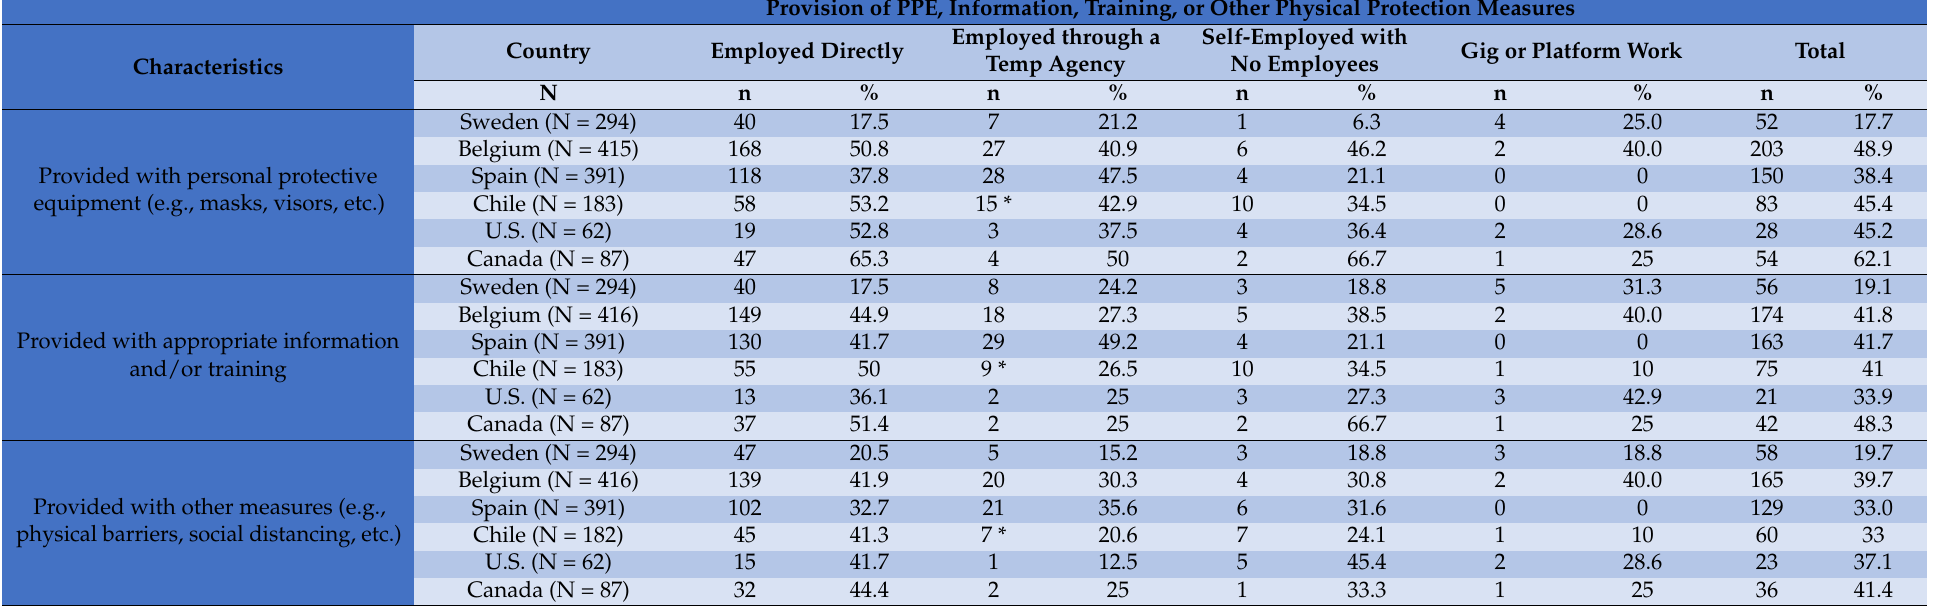
Table 5. Proportion of respondents who worked near infected persons indicating whether they consistently received PPE, information, training, or other protection measures to prevent them from becoming infected, by country and by employment